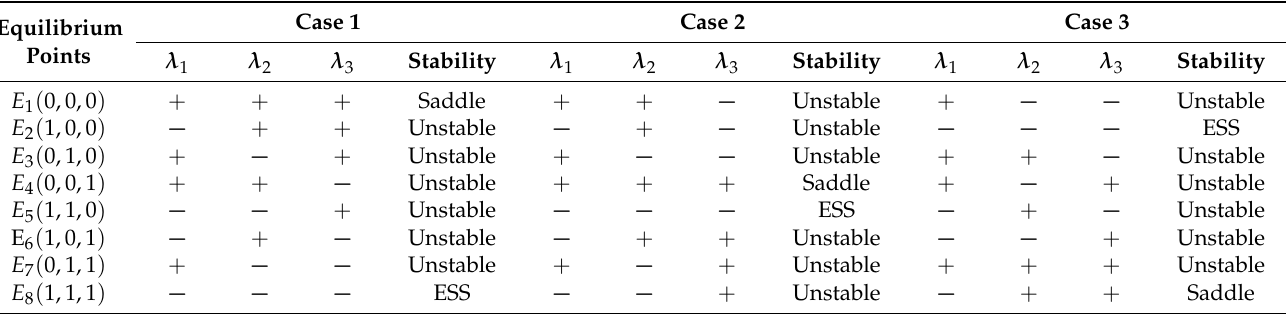
Table 5. Local stability equilibrium